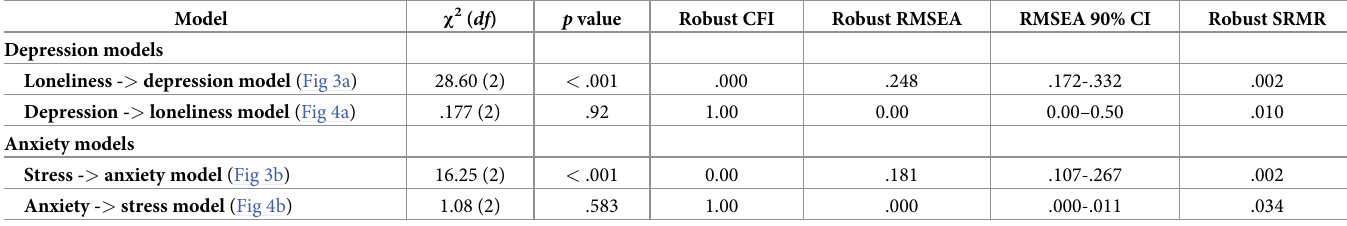
Table 3. Summary of model fit statistics for the alternative path